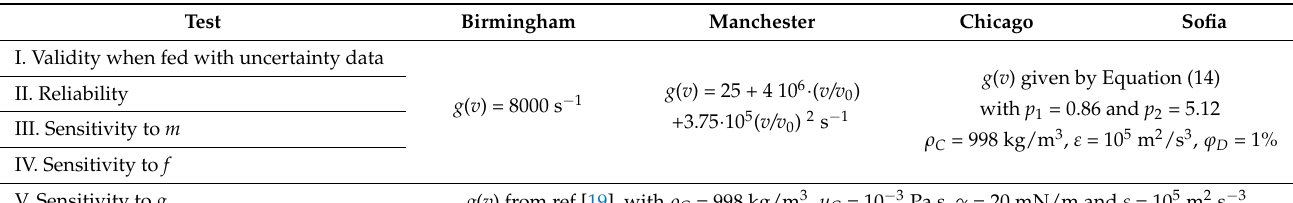
Table 2. Fragmentation rates used to generate the synthetic data in the different tests.